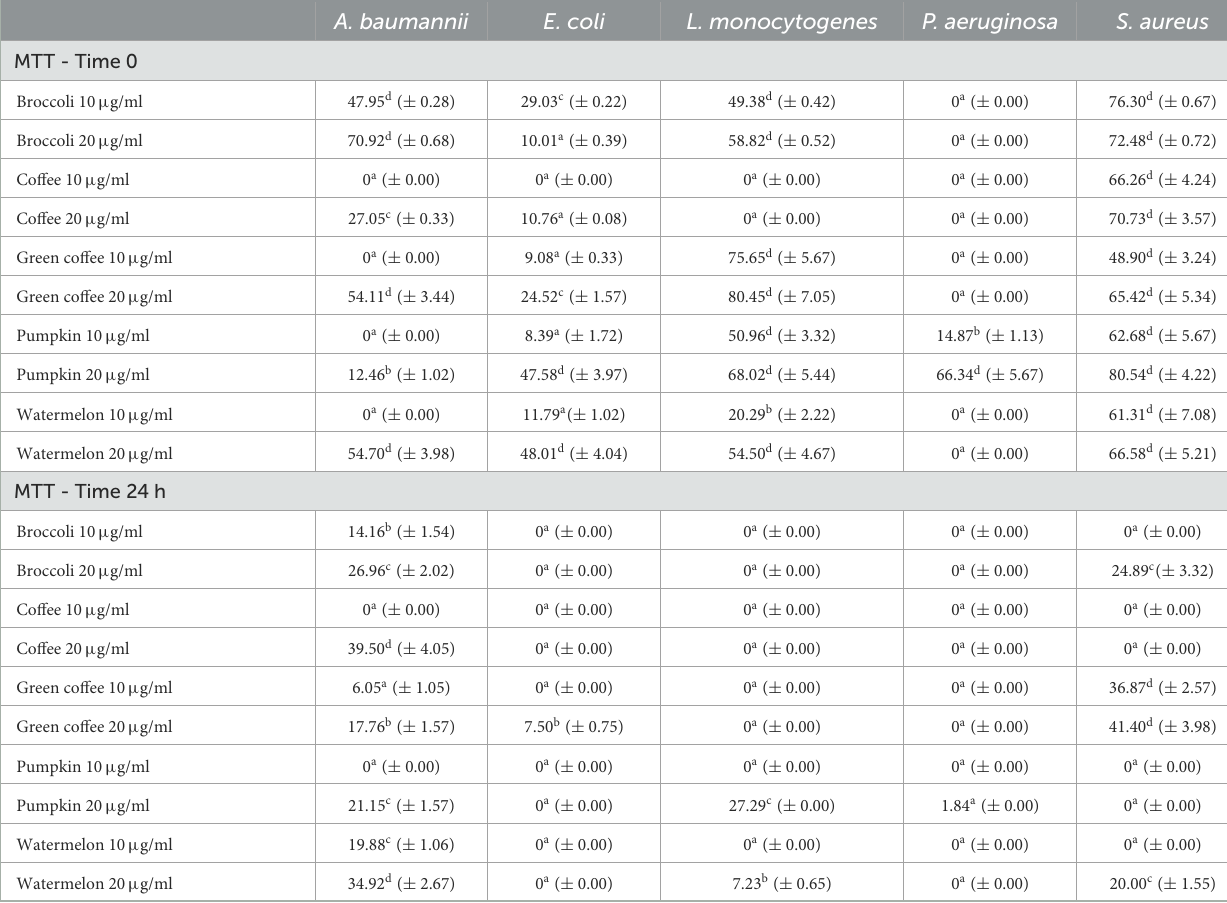
TABLE 5 Inhibitory activity of the seed oils on the bacterial cell metabolism within the biofilm, at 10 µ g/ml and 20 µ g/ml against A. baumannii , E. coli , L. monocytogenes , P. aeruginosa , and S. aureus